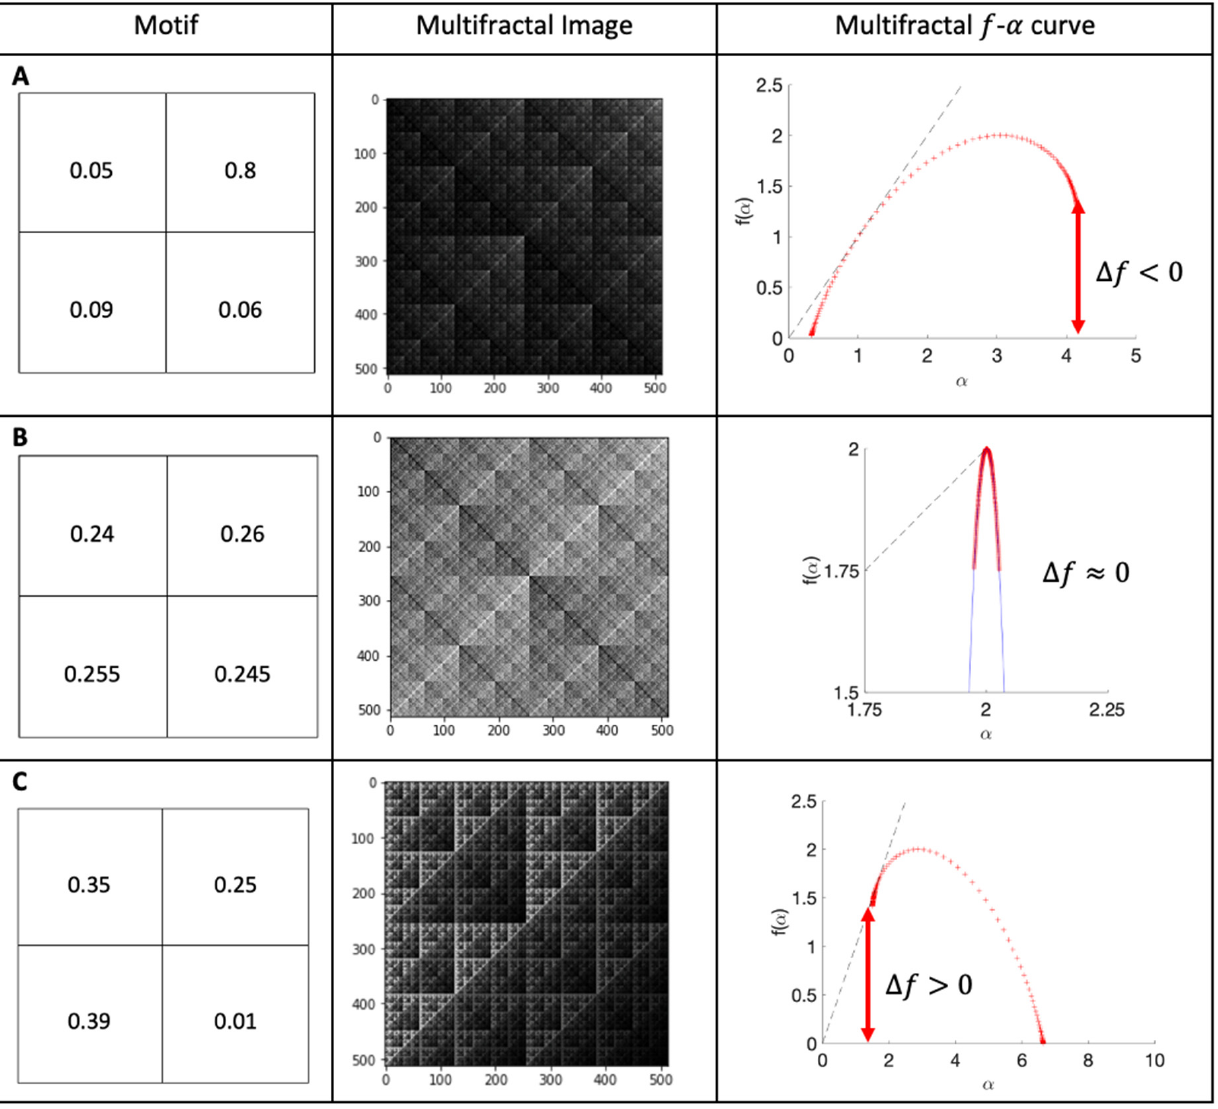
Figure 1. Computed curves for theoretical multifractal images. Motif, multifractal image and com- puted curves: ( A ) clusters of dark pixels; ( B ) homogeneous multifractal; ( C ) clusters of bright pix- els.